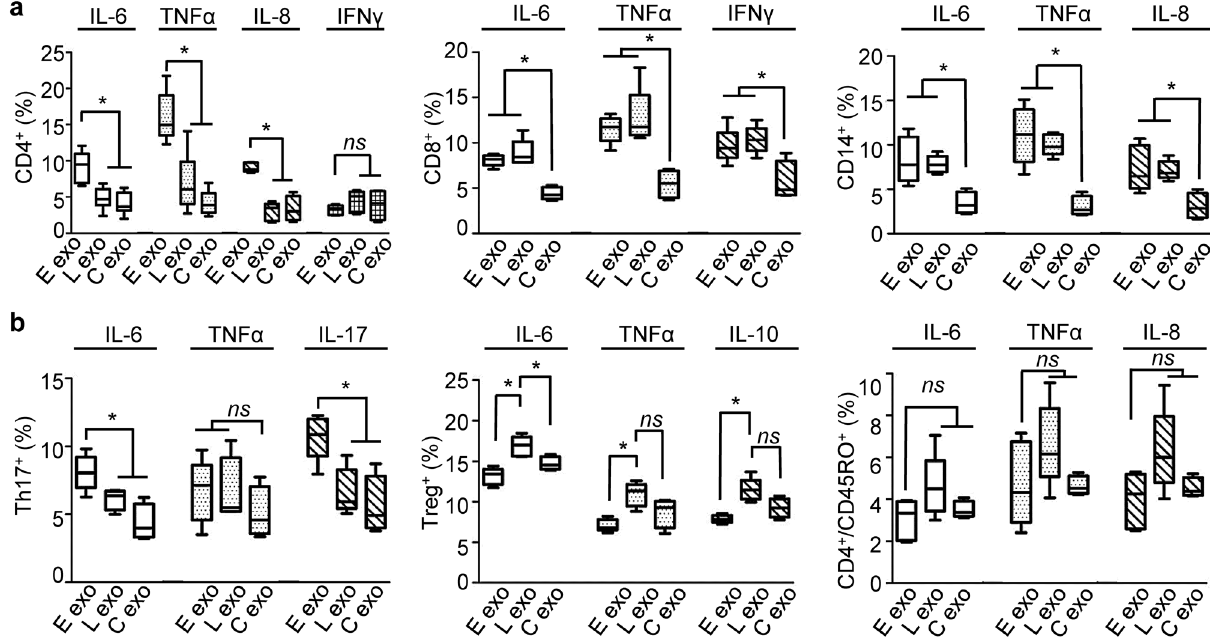
Figure 3. Cytokine production in subsets of immune cells in response to COVID-19 plasma exosomes. ( a ) MicroBeads sorted CD4 + T cells, CD8 + T cells, and CD14 + monocytes were treated with plasma